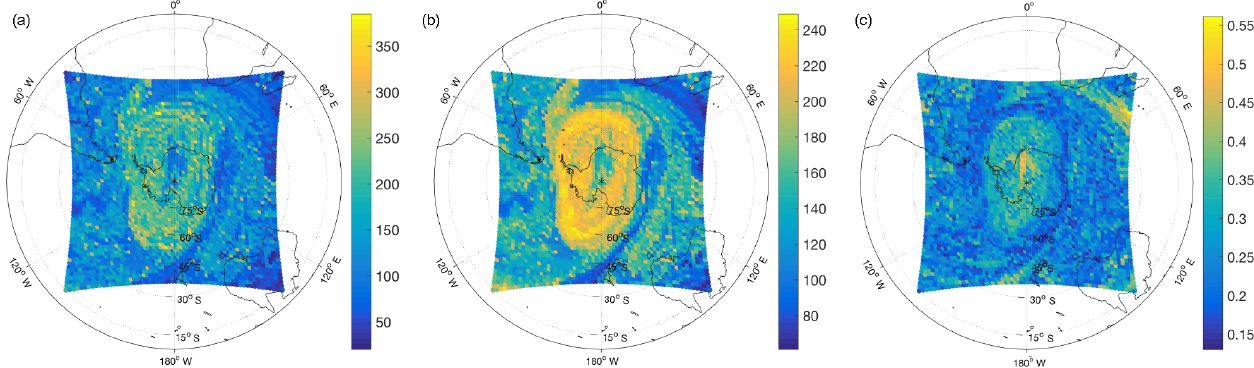
Figure 7. Node degree d (a) , average node degree of neighboring nodes (cid:104) d (cid:105) nn (b) , and clustering coefficient C (c) of a network constructed from trajectories for the polar vortex flow between 1 September and 31 October 2002.